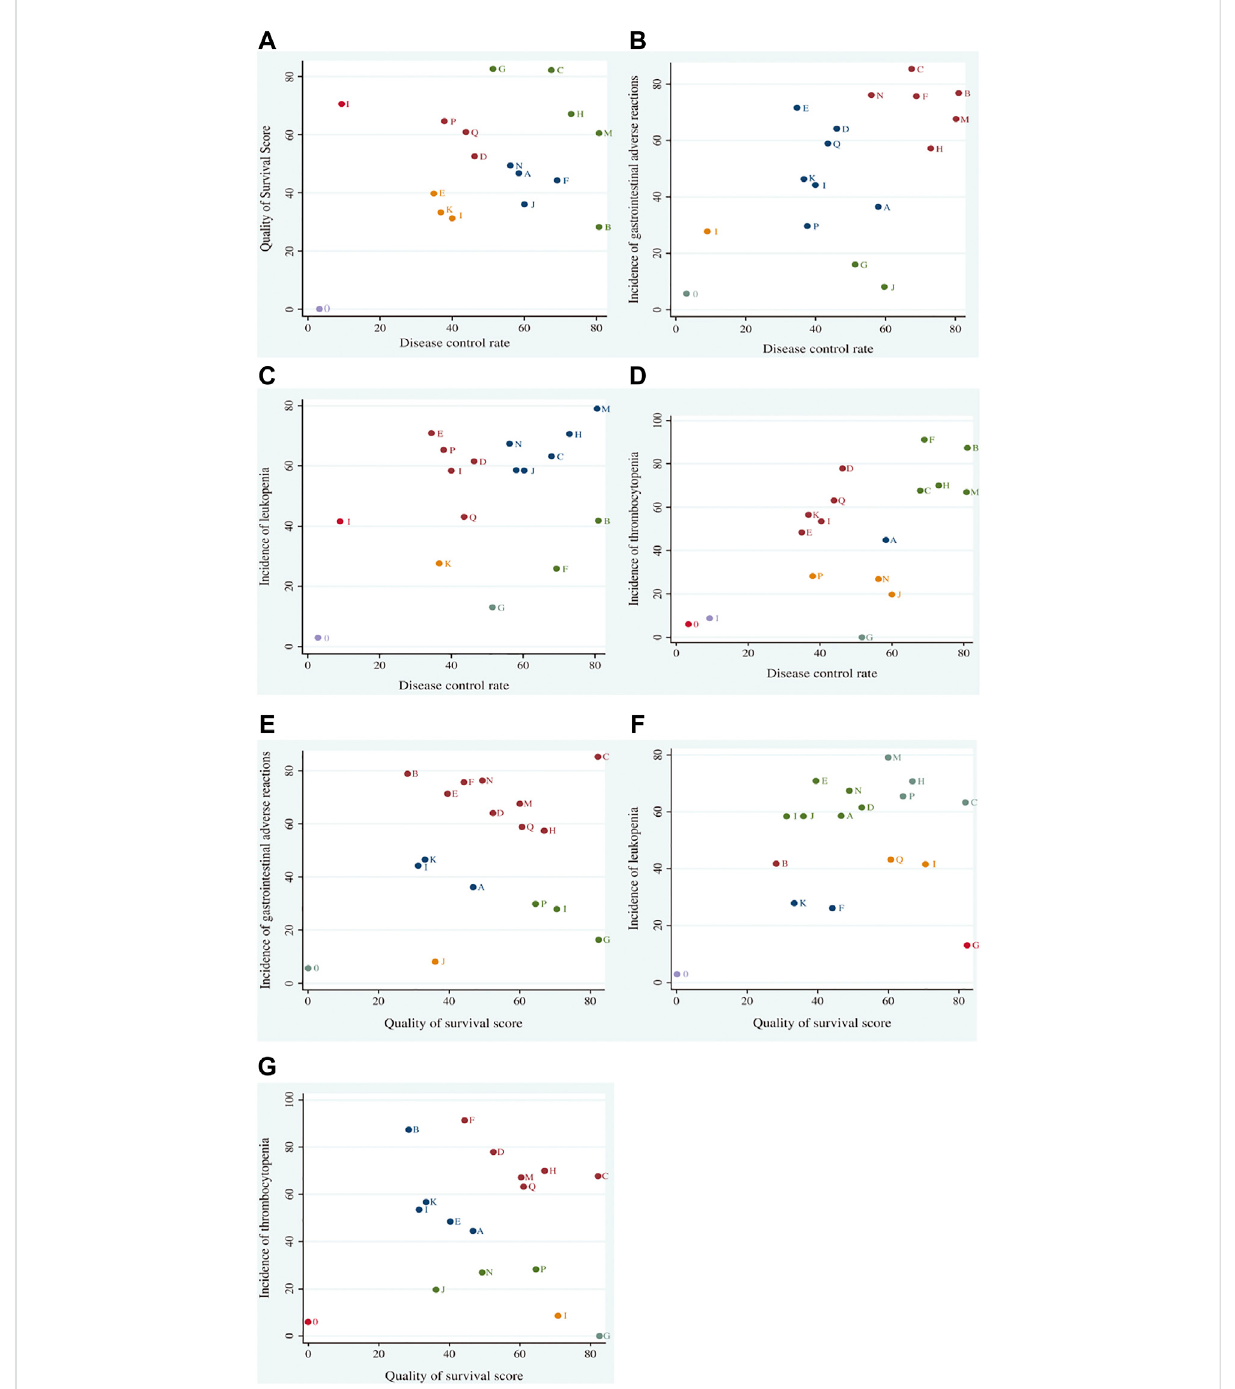
FIGURE 5 Cluster analysis plots for outcomes. Cluster analysis plot of: (A) disease control rate (DCR) and survival quality score, (B) DCR and incidence of gastrointestinal adverse reactions, (C) DCR and incidence of leukopenia, (D) DCR and incidence of thrombocytopenia, (E) survival quality score and incidence of gastrointestinal adverse reactions, (F) survival quality score and incidence of leukopenia, and (G) survival quality score and incidence of thrombocytopenia. Interventions located in the upper right corner indicate optimal therapies for two different outcomes, as follows: A, adi + wm;B,csi+wm;C,dci+wm;D,dlsi+wm;E, fl ksi+wm;F,hcsi+wm;G,hqi+wm;H,kai+wm;I,klti+wm;J,oomi+wm;K,s fi 4-wm;L,si+wtn;M, smi + win; N, sqfzi + wm; 0, wm; P, xapi + wm; Q, xgdti +